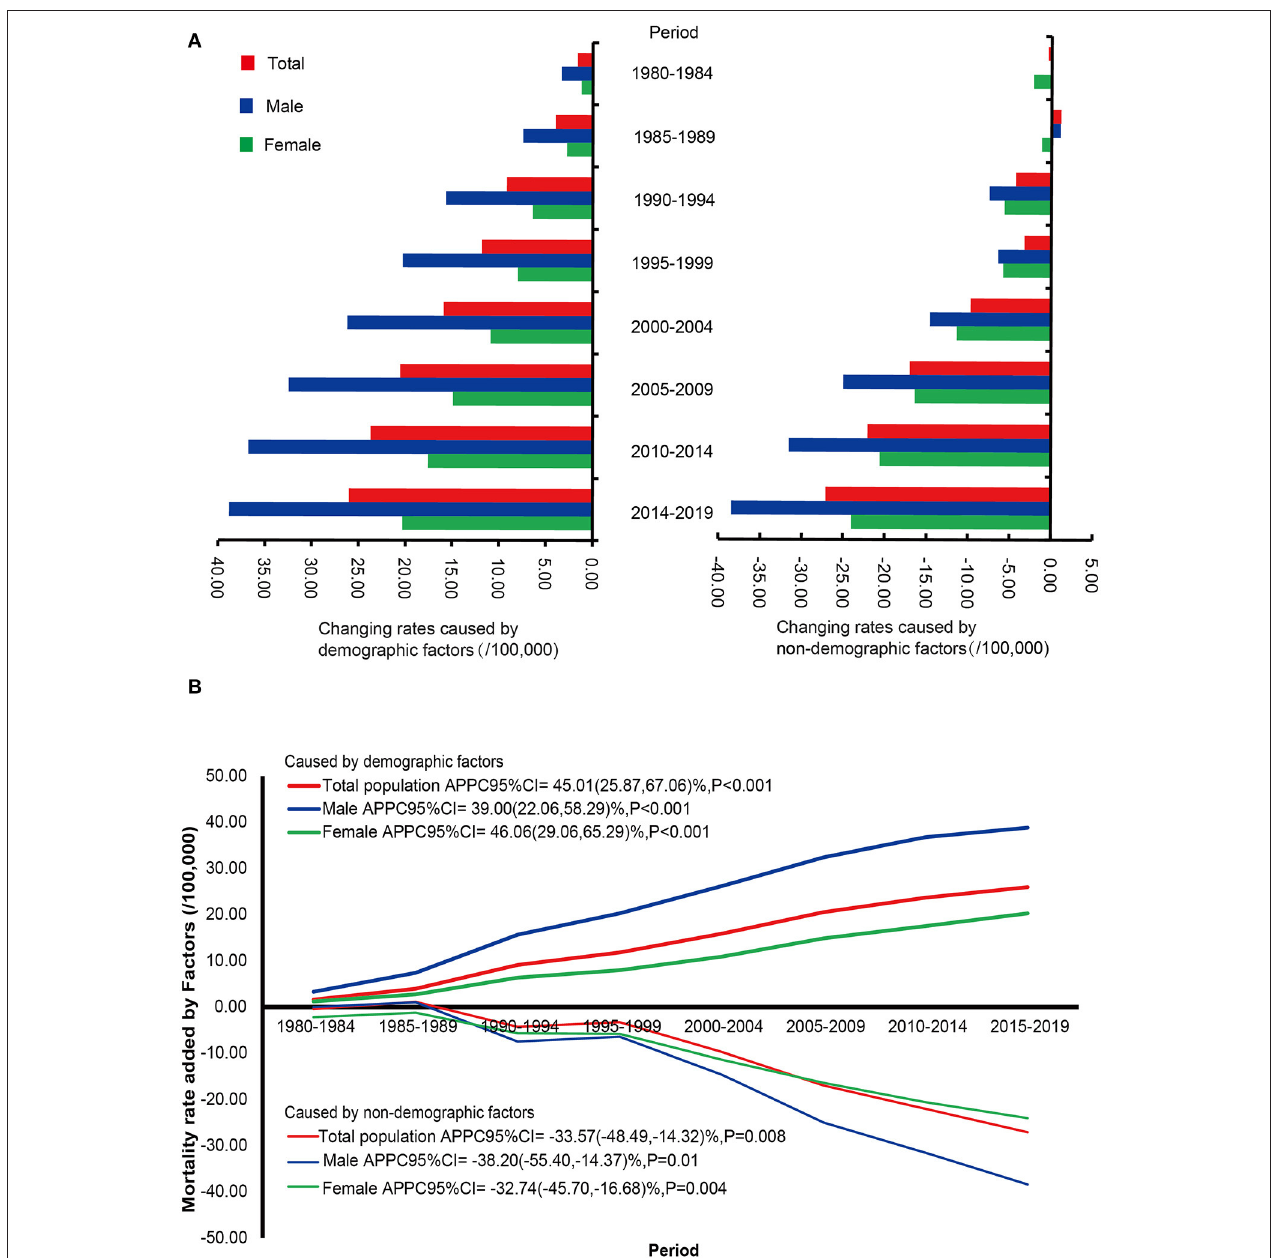
FIGURE 2 | The increased rates caused by demographic and non-demographic factors and their proportion during the period from 1980 to 2019 compared with the crude mortality rate of liver cancer during 1973–1979 in Pudong New Area, Shanghai, China. (A) The increased rates caused by demographic and non-demographic factors, (B) The trends of changing values of crude mortality rate caused by demographic and non-demographic in genders. APPC, average period percentage change; CI, confidence